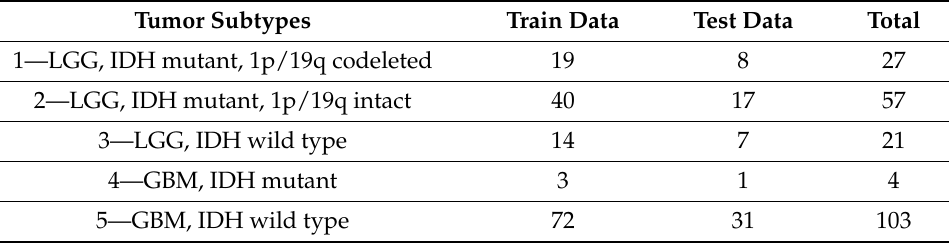
Table A1. Summary of the train and test data regarding different glioma